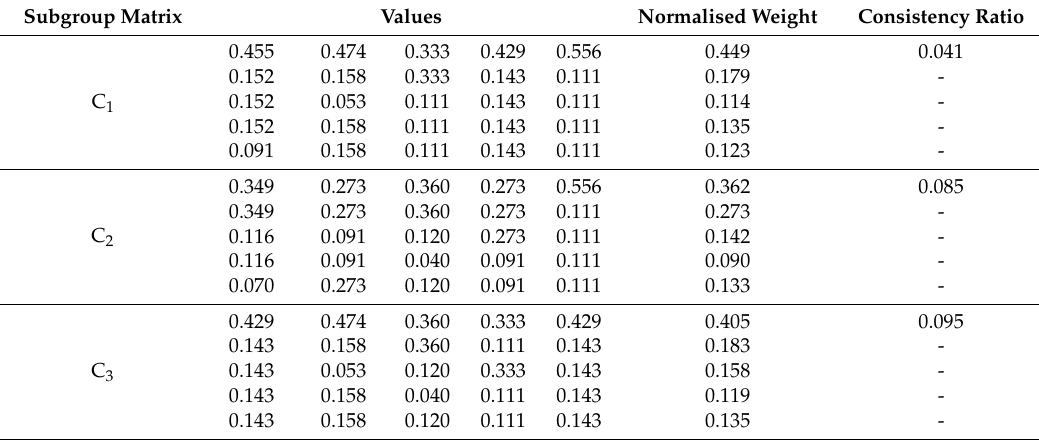
Table 6. Case study: Normalised correlation of